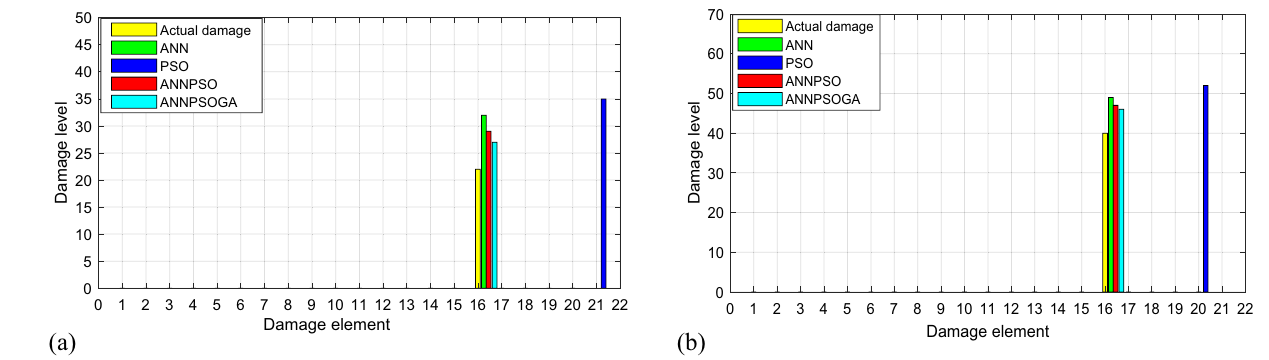
Figure 10. Damage identification employing ANN, PSO, ANNPSO and ANNPSOGA ( a ) 22% damage at element 16 and ( b ) 40% damage at element